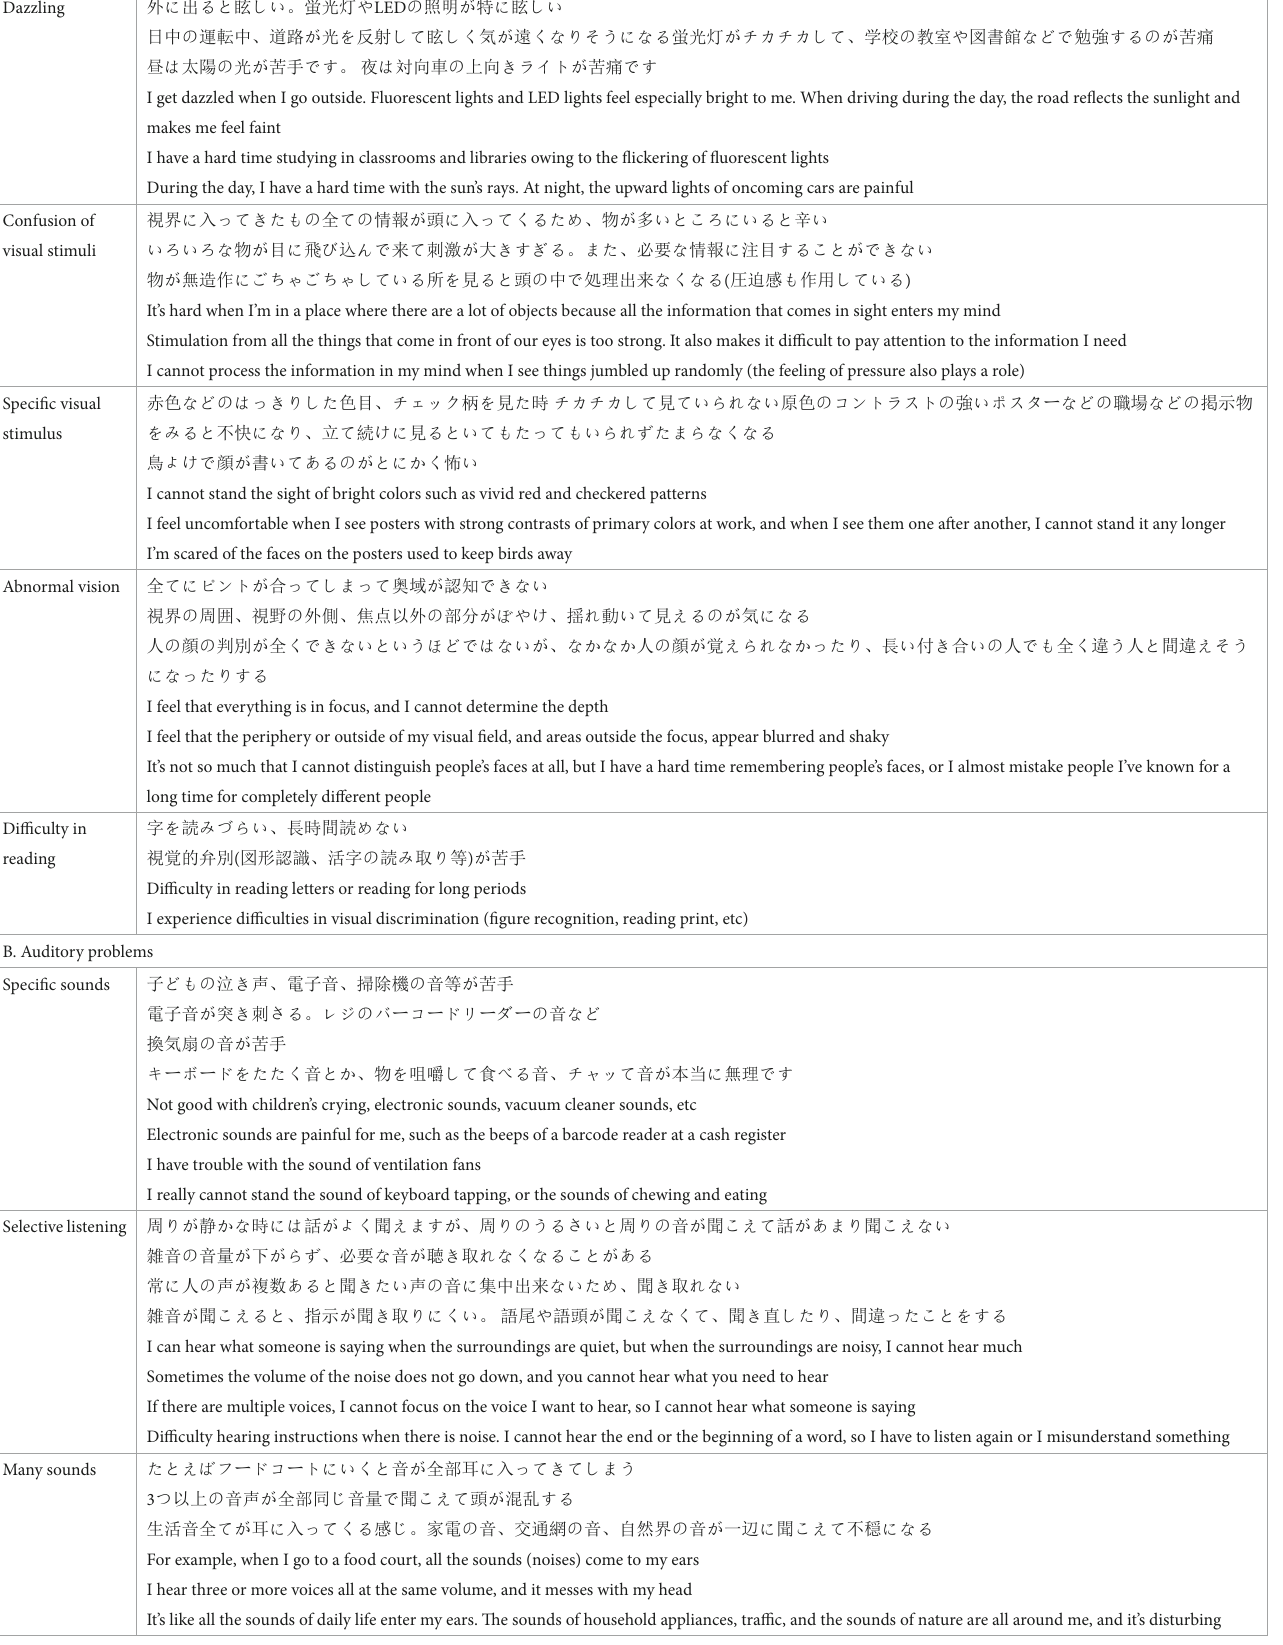
TABLE 3 An example of the descriptions of sensory issues in a free-writing field. A. Visual